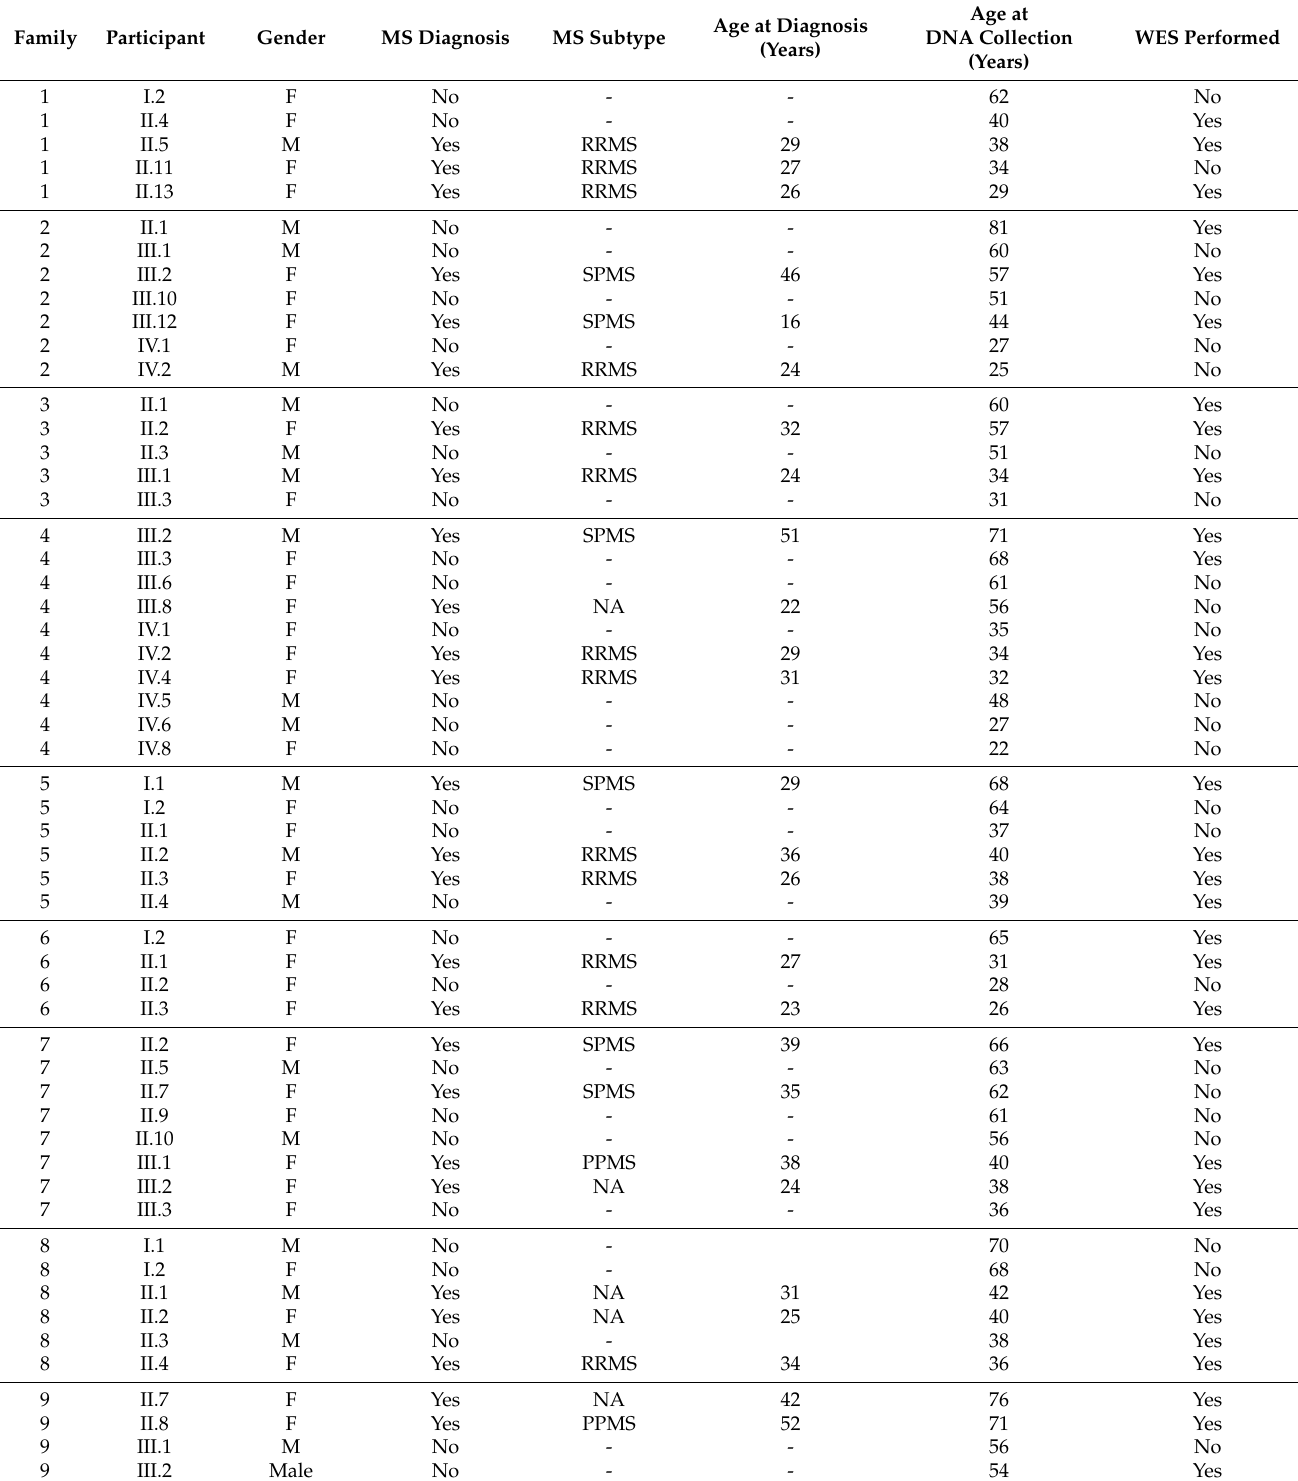
Table 1. An overview of the clinical characteristics of the participants included in the whole exome sequencing (WES) study of MS (26 MS patients and 29 unaffected family members). F: female; M: male; NA: MS type not available; RRMS: relapsing-remitting MS; SPMS: secondary progressive MS; PPMS: primary progressive